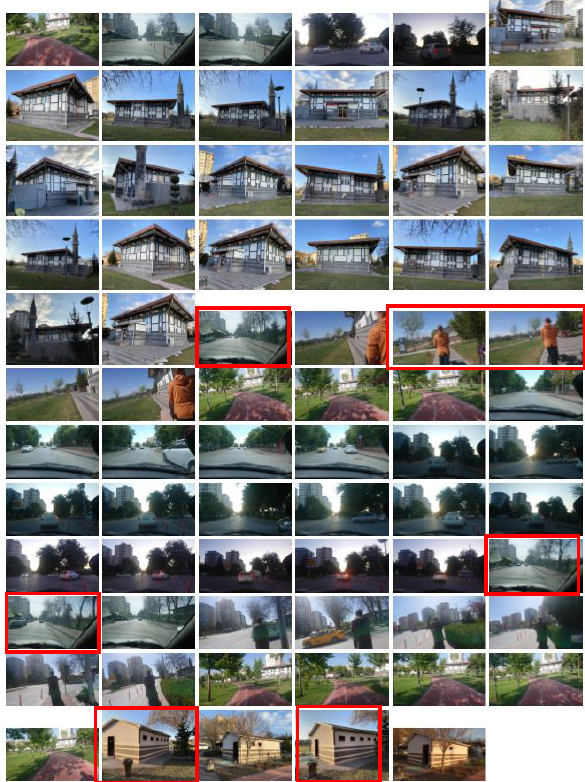
Figure 16. Images selected for target building 5 with 50 °camera view angle threshold, images enclosed with red color are those selected due to wrong cca values indicated in Table 2. Figure 14. Images selected for target building 5 with no angle Flexing minimum and maximum angle with a camera view angle view threshold threshold increased f-score for both target buildings. After testing with different thresholds for TB:5, 50° threshold was providing f-score of 0.95, 3 images were labelled as false positive, not seeing the TB:5 and also 3 images were missed (orange borders shows the part of the target in the Figure